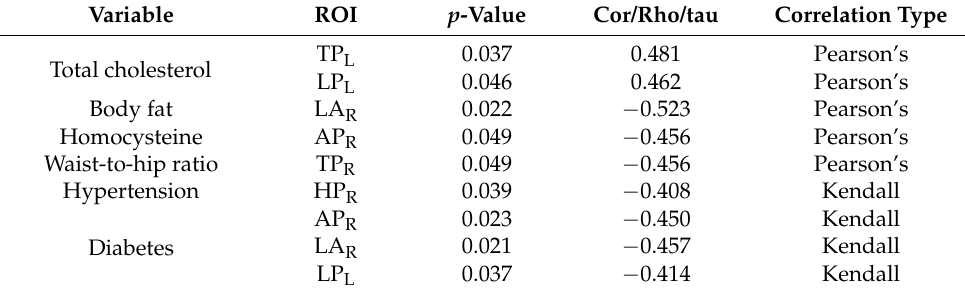
Table 4. Statistical significance results in the control group at ∆ T.